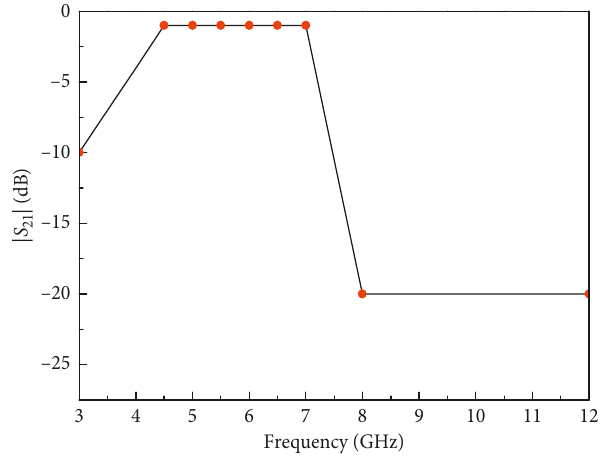
Figure 5: The desired frequency response of the band-pass FSS with steep falling edge. The samplings marked in red color are chosen to show the main properties of the FSS in the passband and